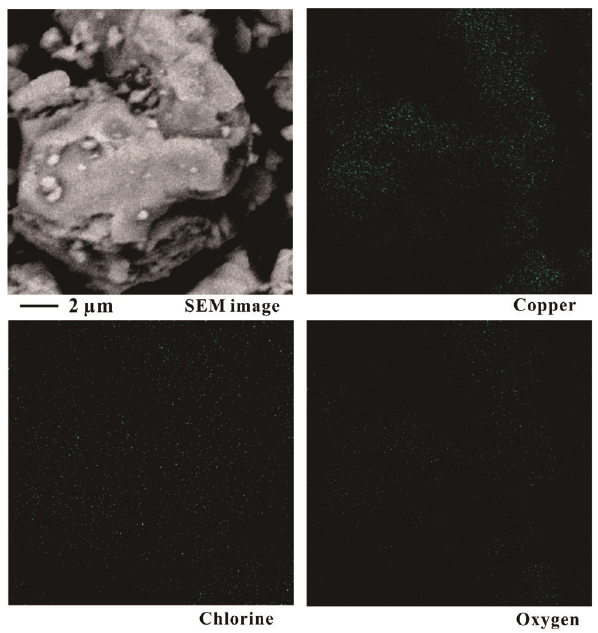
Fig. 12: SEM micrograph of samples after microwave roasting and the Cu, Cl and O X-ray EDS